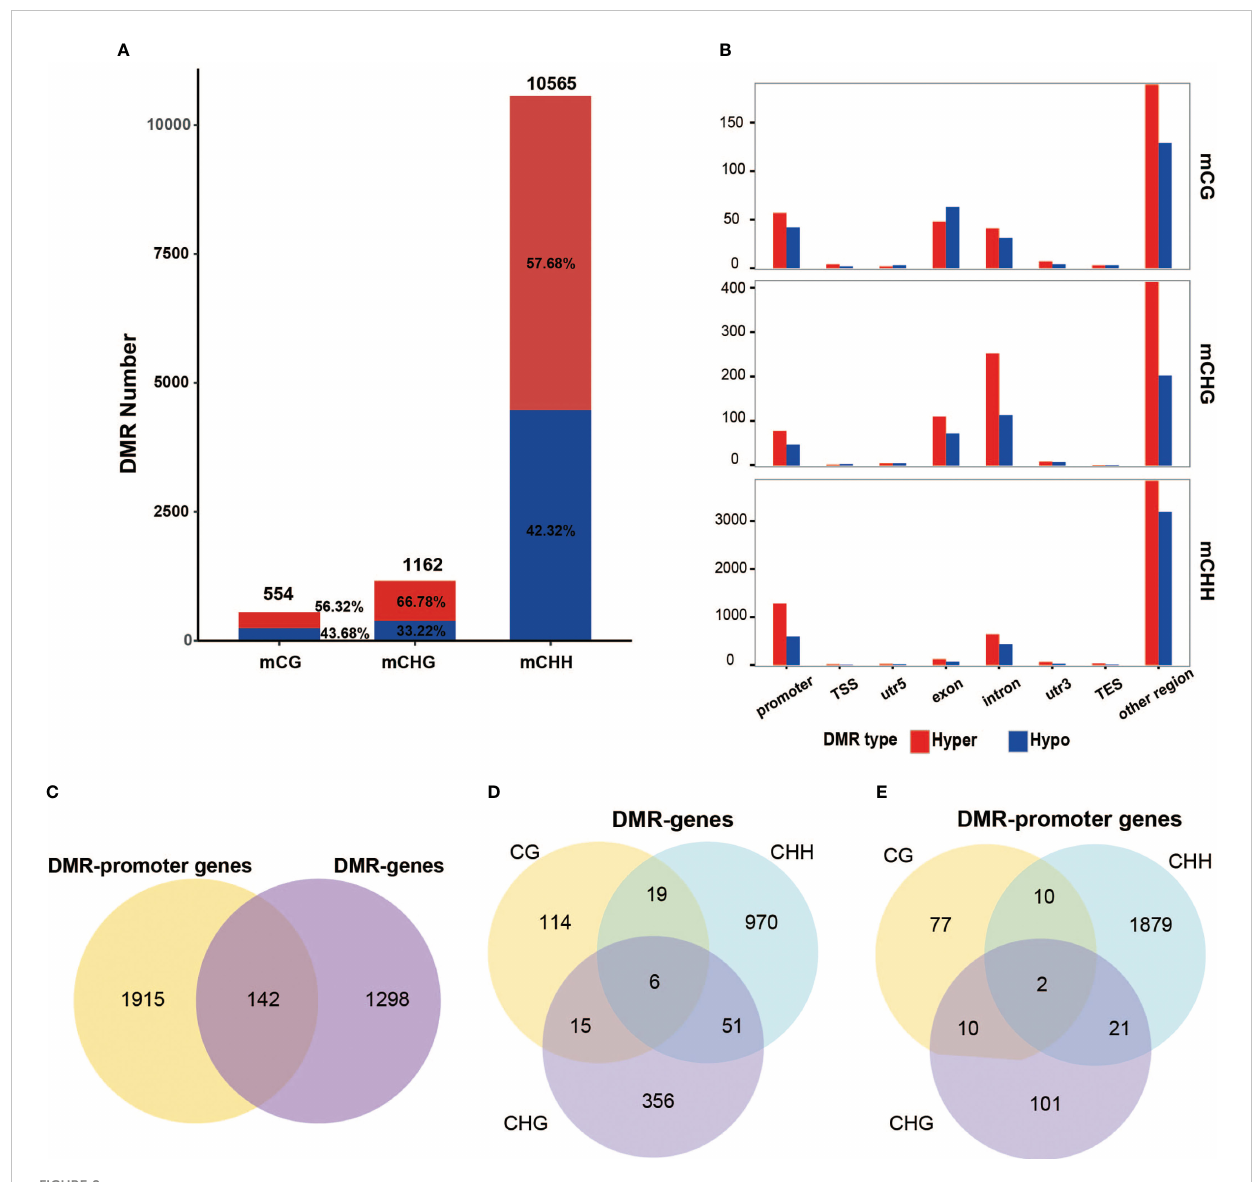
FIGURE 8 Differential methylome analysis for 4X water spinach compared with 2X. (A) Number of differentially hypermethylated and hypomethylated regions in all three contexts. (B) The distribution of DMRs in the genome. (C) Venn diagram of DMR-genes and DMR-promoter genes. (D) Venn diagrams of DMR-genes in all three contexts. (E) Venn diagrams of DMR-promoter genes in all three